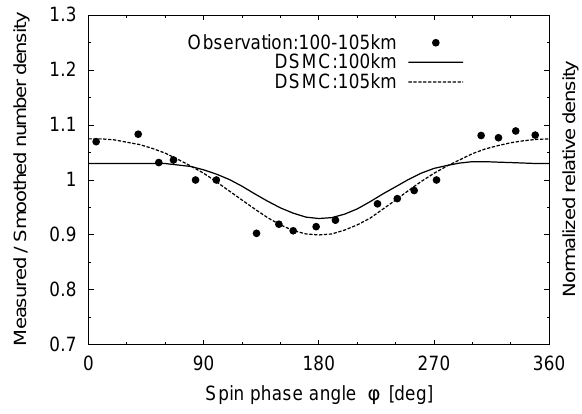
Fig. 7. (a) Relative densities simulating the NTV measurement and (b) normalized relative densities over the spin.